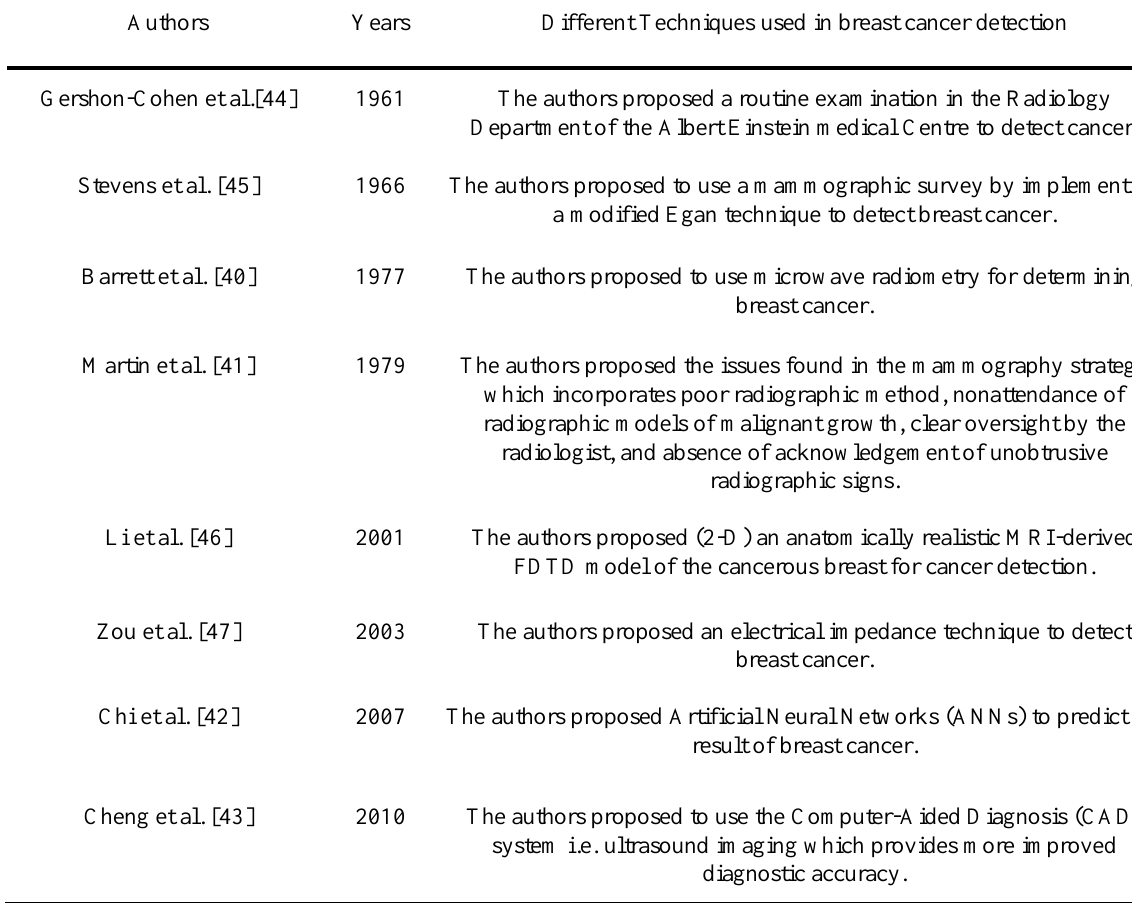
Table 1. A literature review of Breast cancer